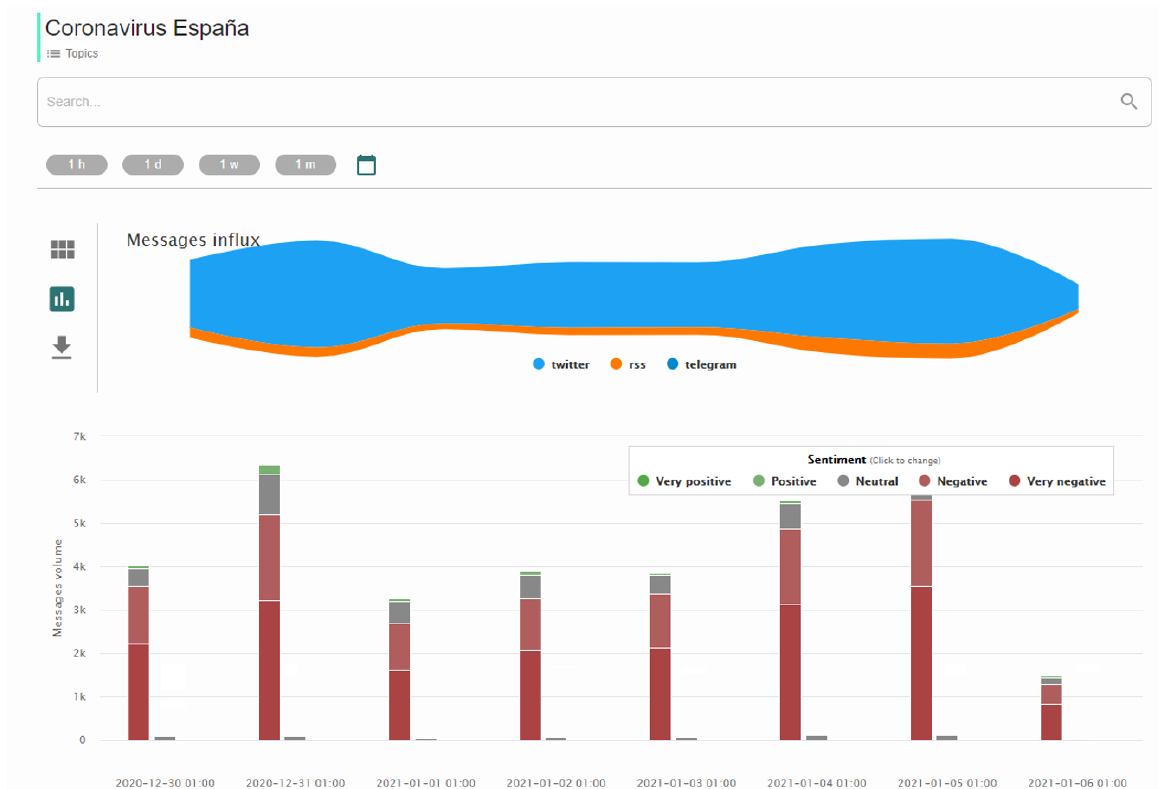
Figure 3. Example of visualisation considering the dates from 30 December 2020 to 6 January 2021.